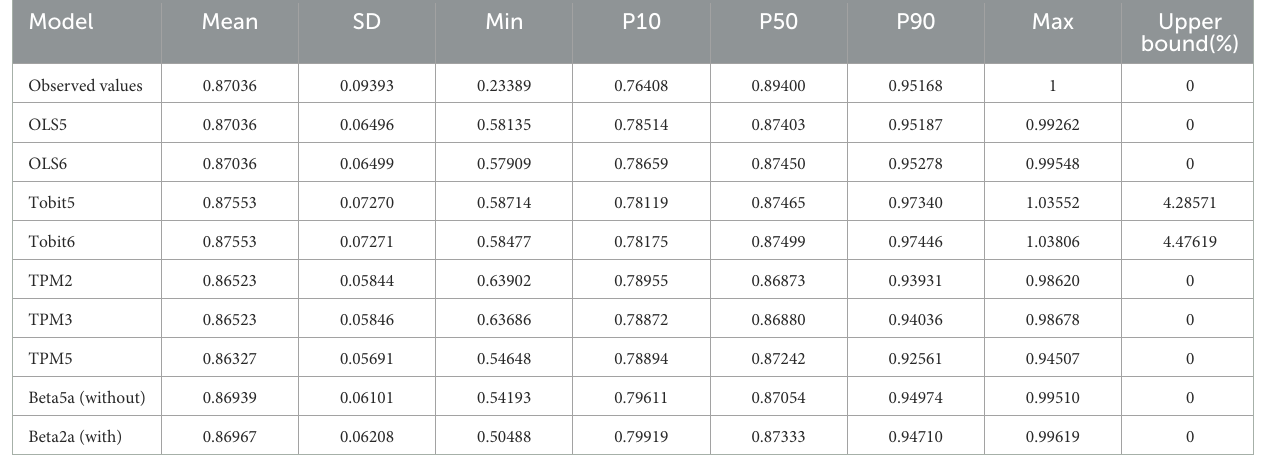
TABLE 5 Predicted and observed values for EQ-5D-5L from the best-fitting model. Model